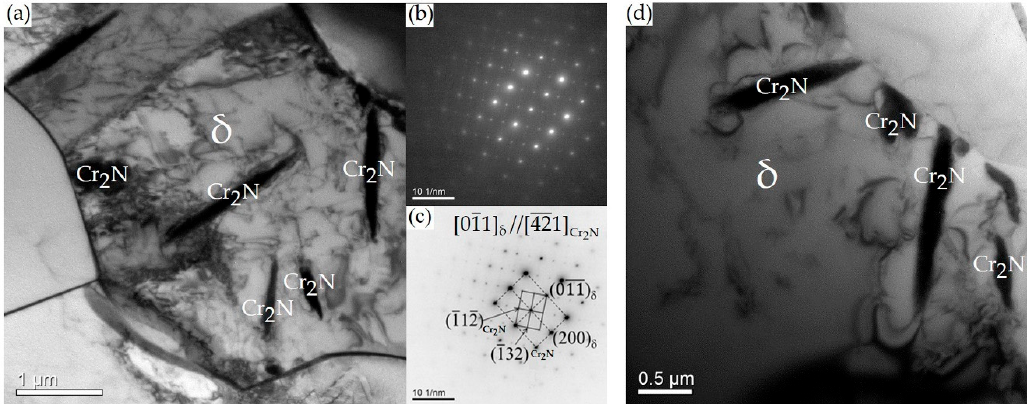
Figure 1. Microstructure of a specimen aged at 600 °C for 7 h ( a ) transmission electron micrograph showing Cr 2 N precipitated within δ -ferrite; ( b ) diffraction pattern with zone [01 (cid:3364) 1] ( c ) interpretation of ( b ); ( d ) Cr 2 N formed at phase